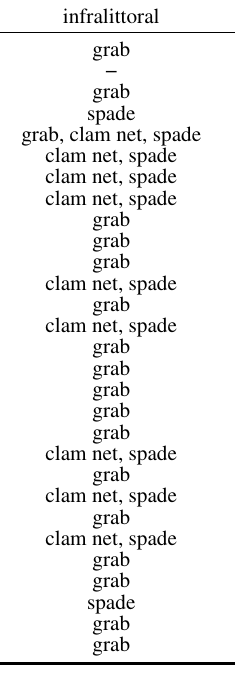
Table 2. – The different substrate types found at each site for the three littoral